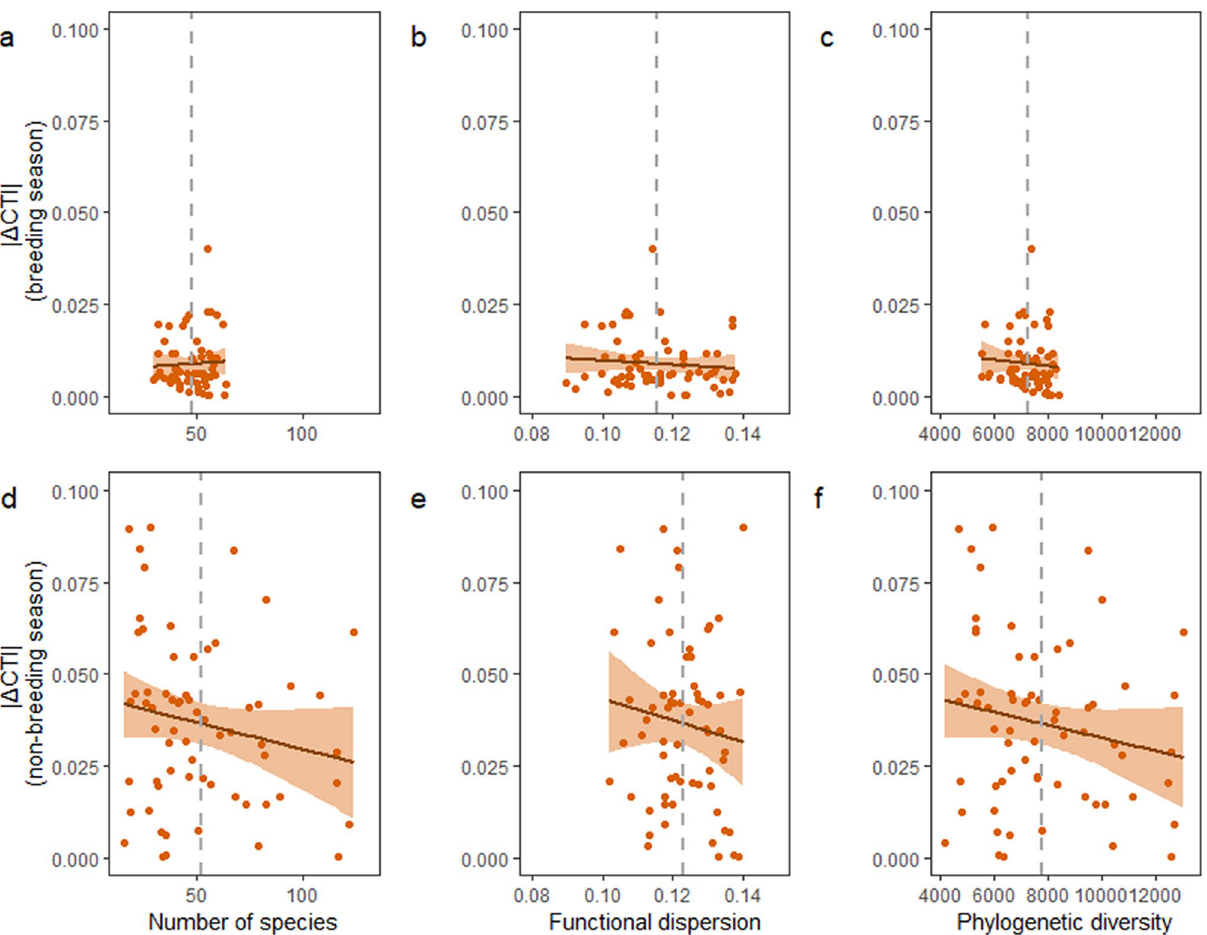
Figure 3. Examples of diversity-thermal variability relationships in breeding and non-breeding seasons. The raw linear relationships with measures of thermal variability and of taxonomic, functional, and evolutionary diversity for each season are illustrated. Thereby, panels ( a ) and ( d ) illustrate the temporal change in community temperature index (|∆CTI|) as a function of the number of species, panels ( b ) and ( e ) illustrate |∆CTI| as a function of the functional dispersion, and panels ( c ) and ( f ) illustrate |∆CTI| as a function of the phylogenetic diversity within the community. The mean of each diversity measure across grid cells is indicated with a grey dashed vertical line. Note that the effect of temperature trend or the spatial correlation structure are not accounted for in the model structures of the illustrated relationships (for full model statistics, see Appendix S1: Table S3). Figure was produced using R software (Version 3.5.3. URL: http:// www.r- proje ct.